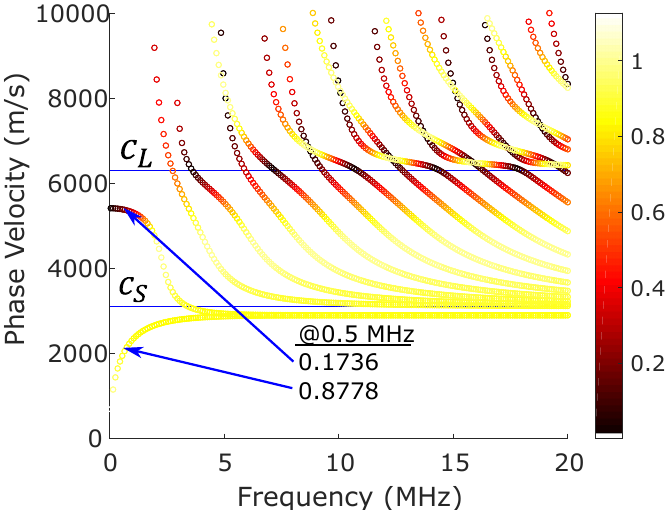
Figure 3. Normalized acoustic leakage, m, is represented as a color scale and overlaid on the dispersion curves for a 1-mm thick aluminum plate. Aluminum properties: c l = 6350 m/s, c S = 3100 m/s and ρ = 2700 kg/m 3